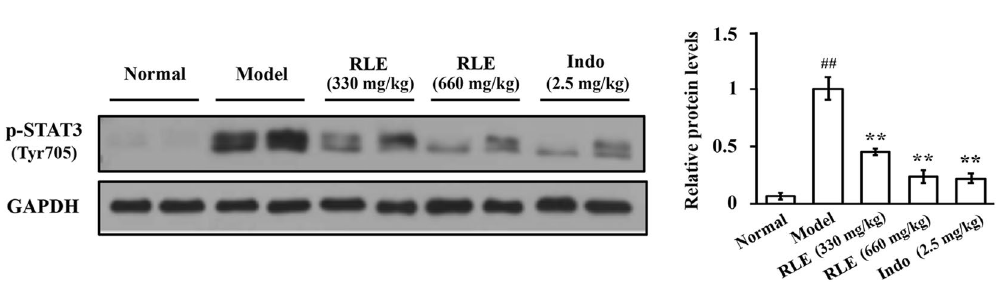
Figure 4. RLE lowered the protein level of p-STAT3 in synovial tissues of CIA rats. Rat tissues were collected in a previous study (n = 6; randomly selected 6 from 8 rats in each group). Protein levels were examined using immunoblotting. Representative blots are shown in left panels. Protein levels relative to loading controls were analyzed using ImageJ software, and are shown in right panels. ** P < 0.01 vs. model group. ## P < 0.01 vs. normal